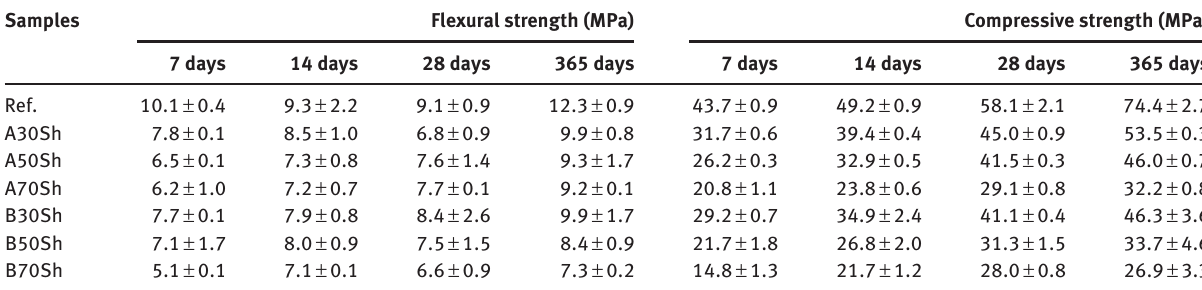
Table 3: Mechanical properties test results.